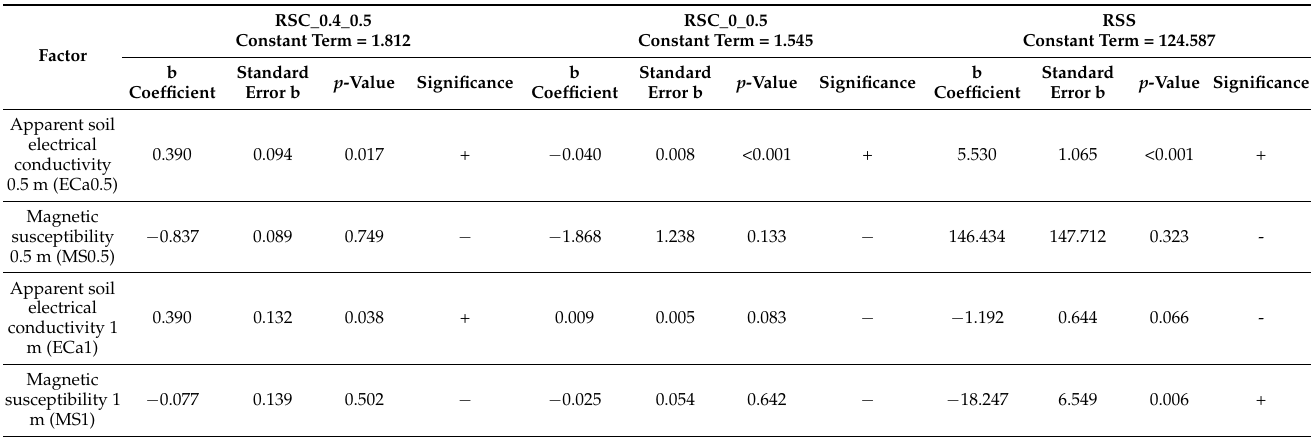
Table 2. Regression coefficients and probability levels for regression